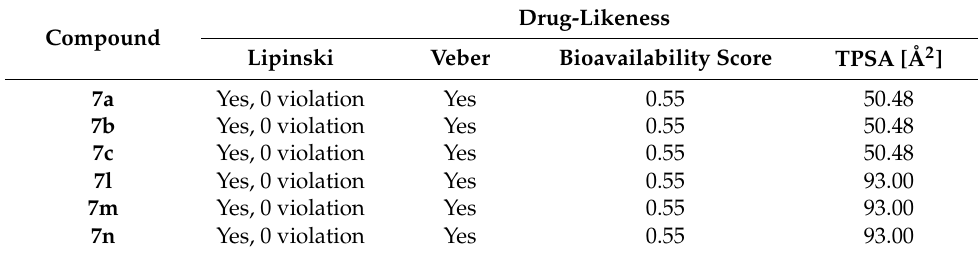
Table 18. Predicted drug-likeness features of investigated derivatives (according to SWISSADME